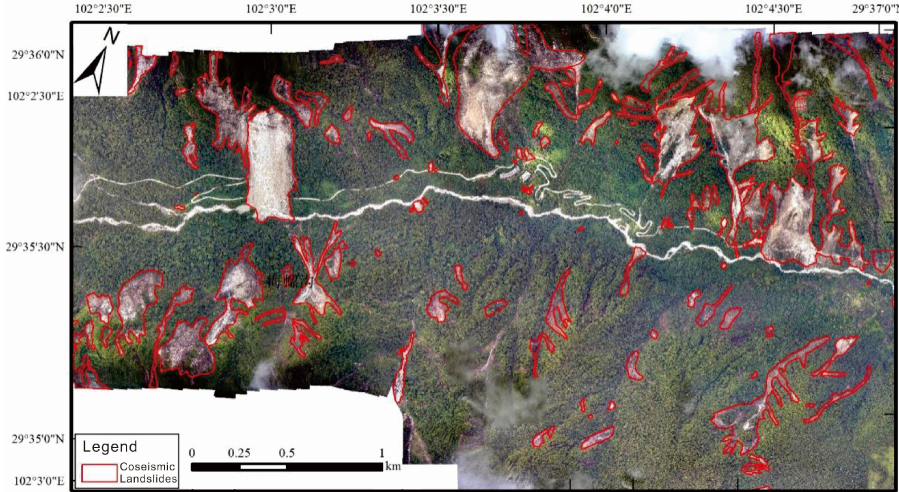
Figure 3. Distribution of coseismic landslides in the most severely struck region of Hailuogou catchment area, shot by drone. A total of 656 identified coseismic geological hazards (3.2 km 2 ) cover 7.4% of the whole range in this